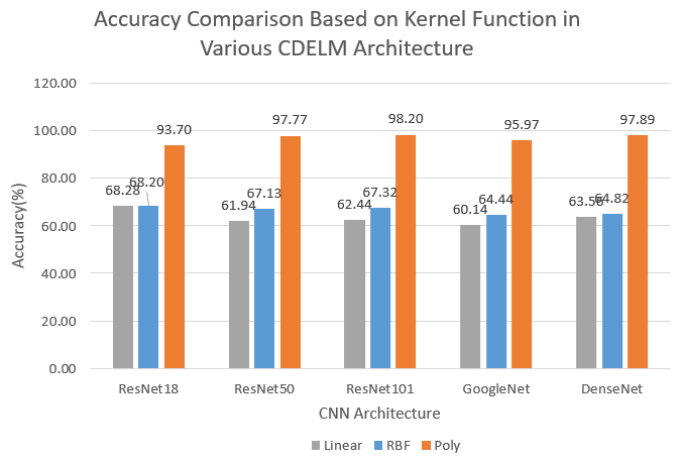
Figure 13. Results of Experiment on 4 class MESSIDOR Dataset.